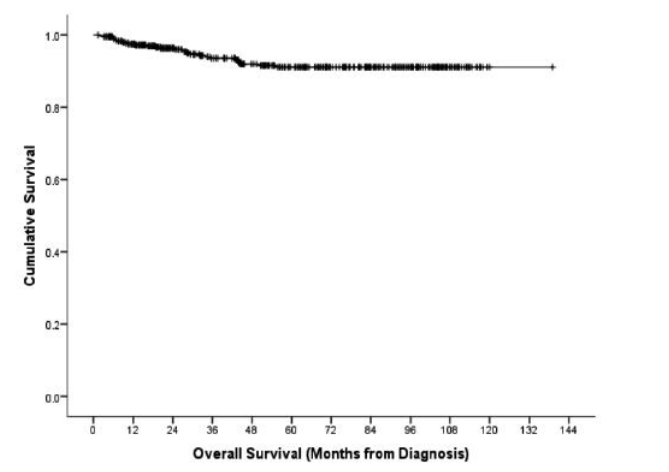
cohort.Figure 1. Overall survival of the whole cohort.